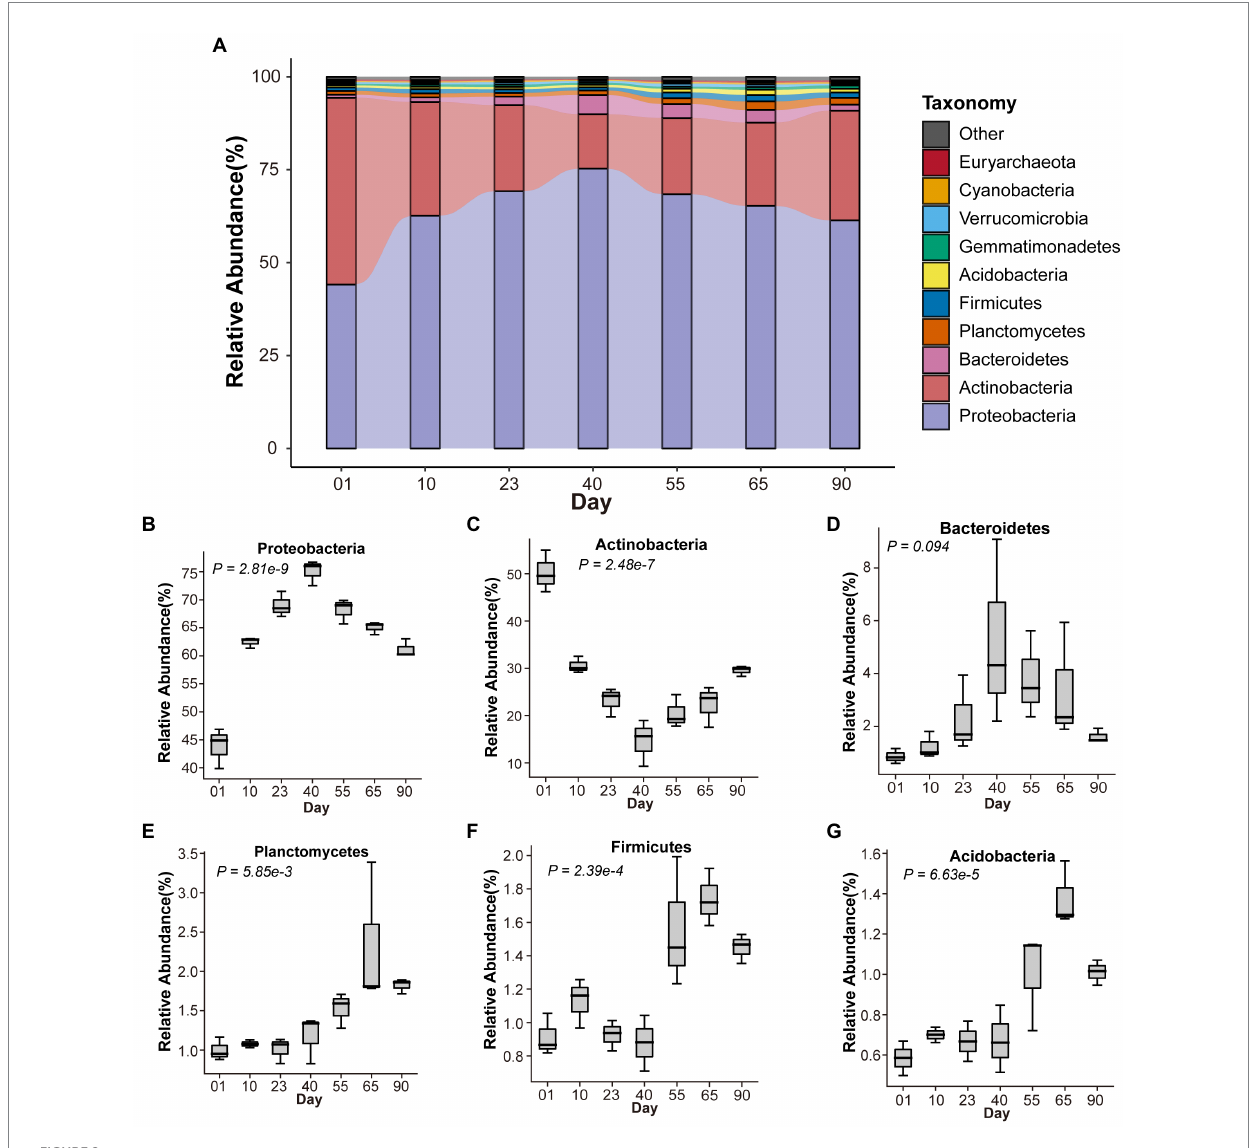
FIGURE 2 Composition of the soil microbiome at different growth stages of Morchella sextelata . (A) Relative abundances of the top 10 most abundant phyla at different time points. (B–G) Variation in microbial phyla during M. sextelata